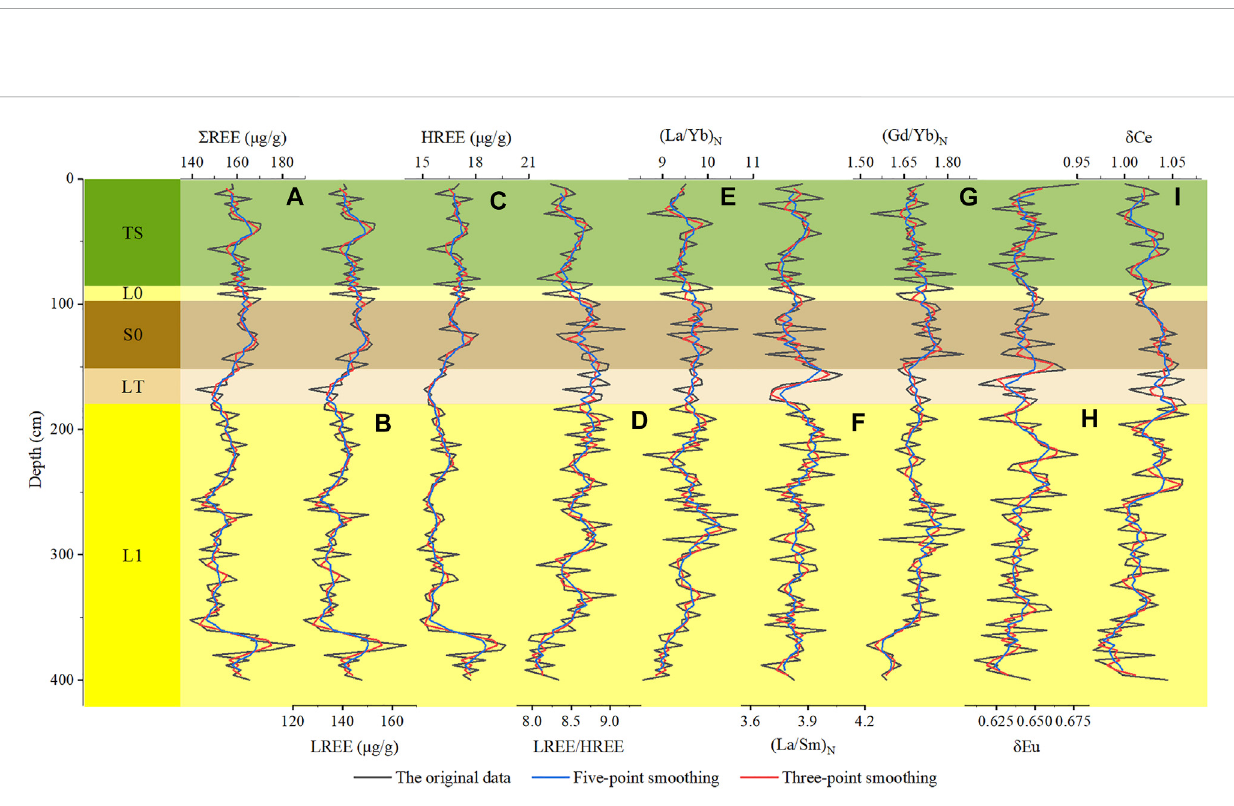
weathering and climate change in the Menyuan loess, and further elucidation of these rare earth elements indices is not suitable as an index of chemical weathering intensity in this area. The relationship